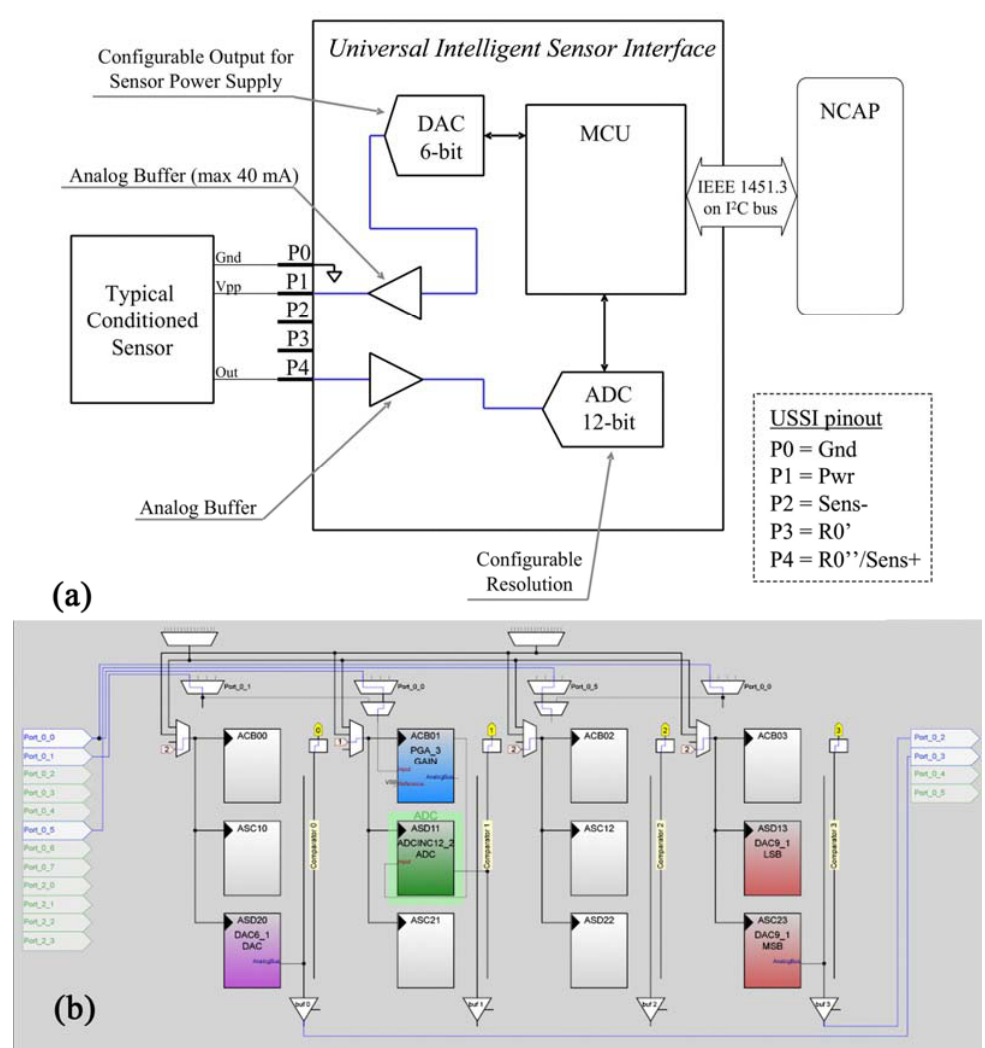
Figure 5. Conditioned Sensors: (a) Logical scheme of UISI conditioning front-end and (b) screen-shot of related implementation in PSoC device through by means of Graphic